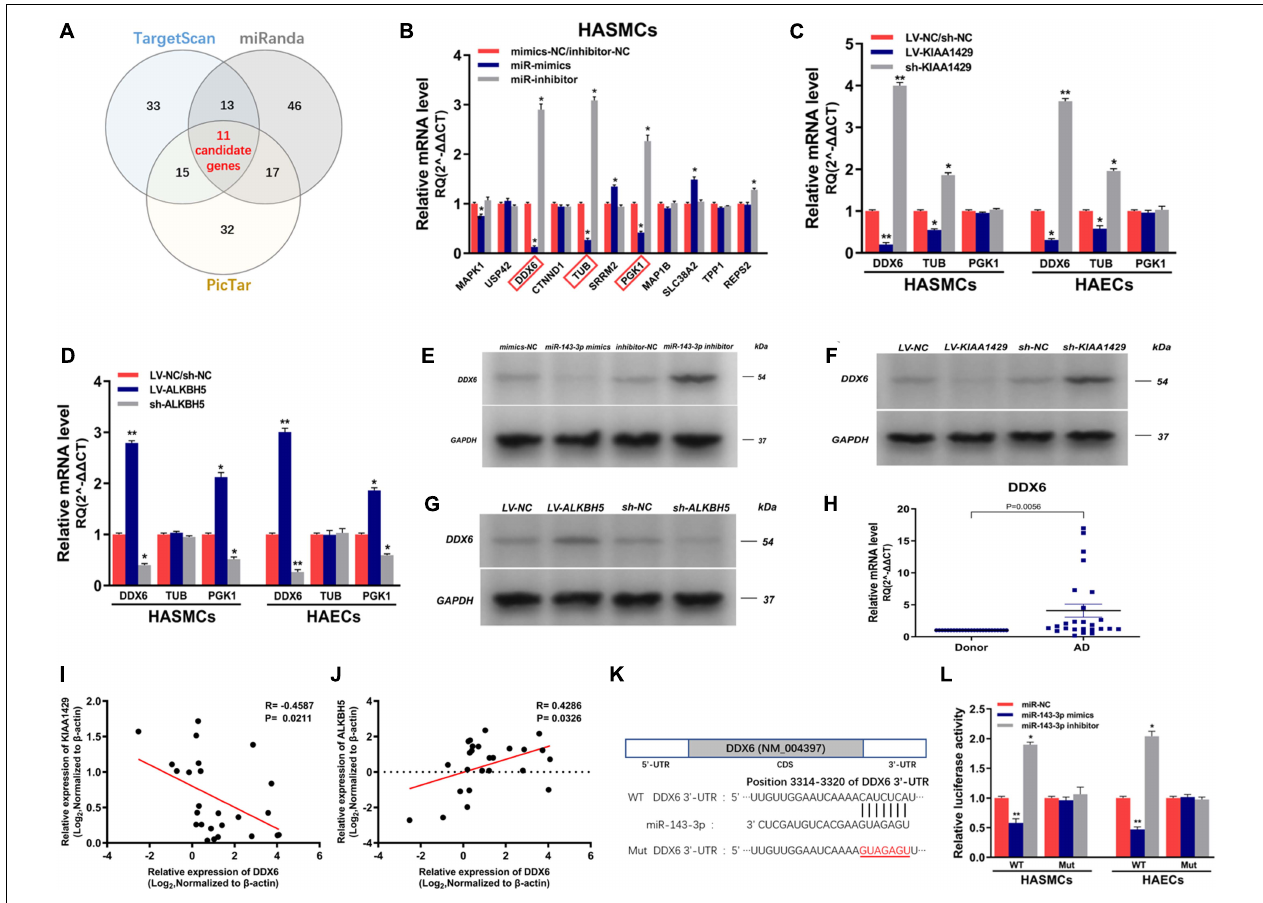
FIGURE 7 | MiR-143-3p directly targets DDX6 in HASMCs and HAECs. (A) We searched for putative targets using three databases and obtained 11 candidate genes in their intersection. (B) The levels of DDX6, TUB, and PGK1 both changed after the upregulation and downregulation of miR-143-3p. (C) The expressions of DDX6 and TUB were reduced or elevated after the overexpression or silence of KIAA1429, respectively. (D) Only the levels of DDX6 and PGK1 changed with the upregulation or downregulation of ALKBH5. (E–G) Western blot assays confirmed the regulatory effects of miR-143-3p, KIAA1429, and ALKBH5 on the expression levels of DDX6. (H) The high expression of DDX6 in aorta samples from AD patients was confirmed by qRT-PCR. (I,J) A negative correlation between DDX6 and KIAA1429 ( R = –0.4587, p = 0.0211) and a positive correlation between it and ALKBH5 ( R = 0.4286, p = 0.0326) were identified by Pearson’s correlation coefficient analysis. (K) The 3 (cid:48) -UTR of DDX6 was analyzed and one conserved binding domain for miR-143-3p was identified. (L) The variations of miR-143-3p level in the 3 (cid:48) -UTR-Wt group significantly decreased or enhanced the luciferase activity, respectively, while the luciferase activity remained unchanged in the 3 (cid:48) -UTR-Mut group. Data are presented as the mean ± SEM ( N ≥ 3 per group); * p < 0.05, ** p <